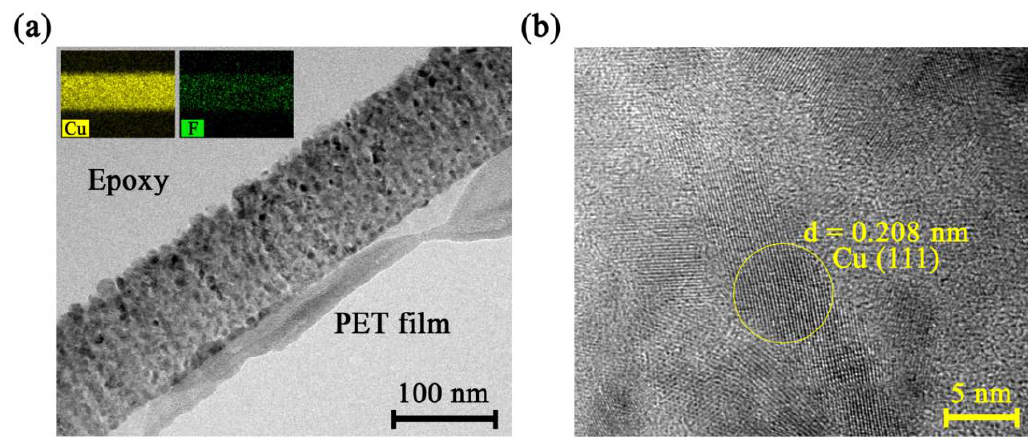
Figure 2. ( a ) Cross-sectional TEM image of the Cu 80 MF thin film and element mapping images, ( b ) nanocluster Cu in PPFC thin film matrix. ( b ) nanocluster Cu in PPFC thin film